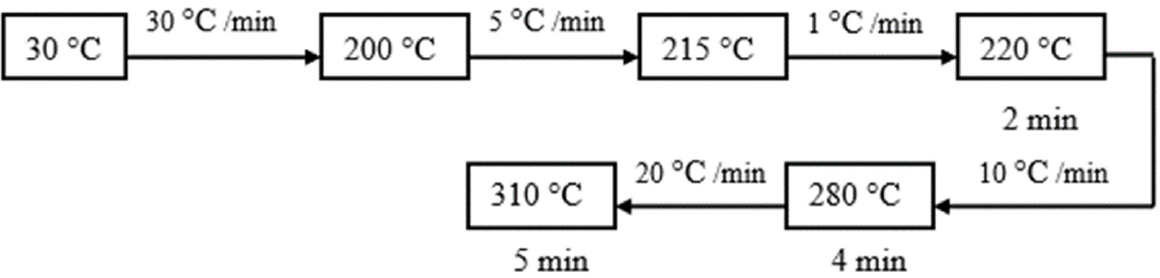
Figure 3. The oven temperature gradient for fatty acid methyl esters.